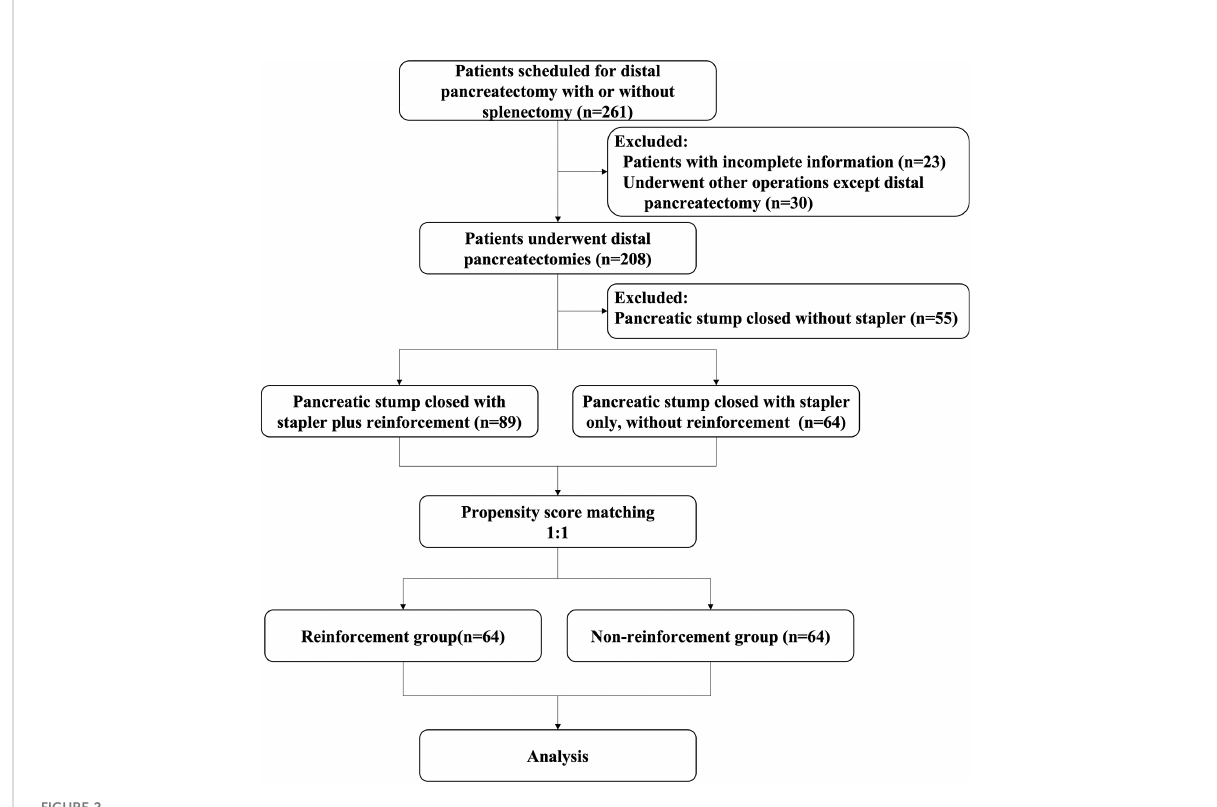
FIGURE 2 Study pro fi